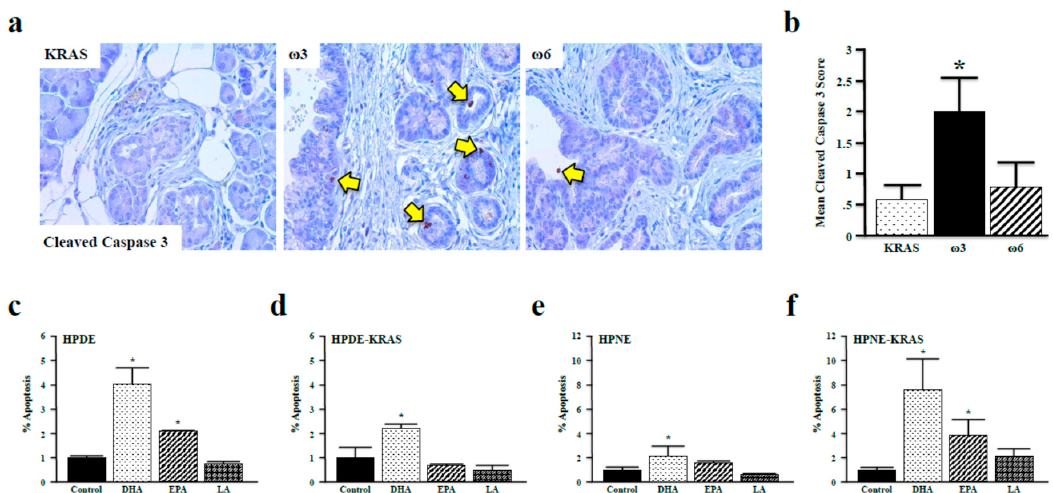
Figure 6. ω 3 fatty acids promote apoptosis in vivo and in vitro. ( a , b ) Apoptosis was assessed in KRAS mice fed control, ω 3, or ω 6 diets (11 months) by immunohistochemistry for the surrogate marker cleaved-caspase 3. ( c – f ) Quantification of cell death (%) by apoptosis was performed in the HPDE, HPDE-KRAS, HPNE, and HPNE-KRAS cell lines incubated with the ω 3 fatty acids DHA and EPA,